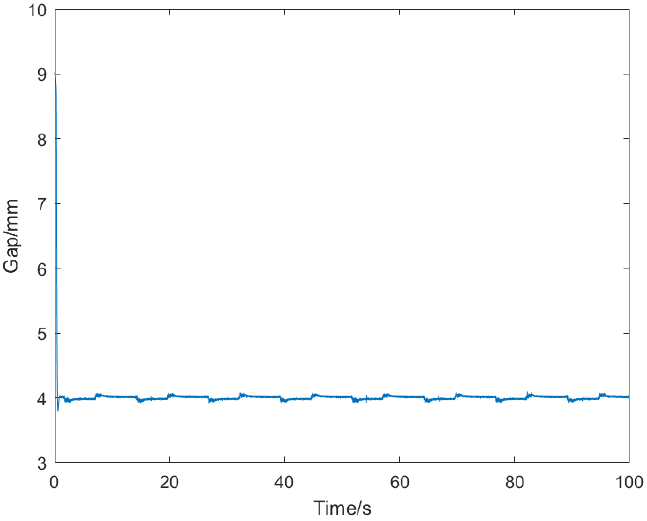
Figure 5. Gap during normal operation.